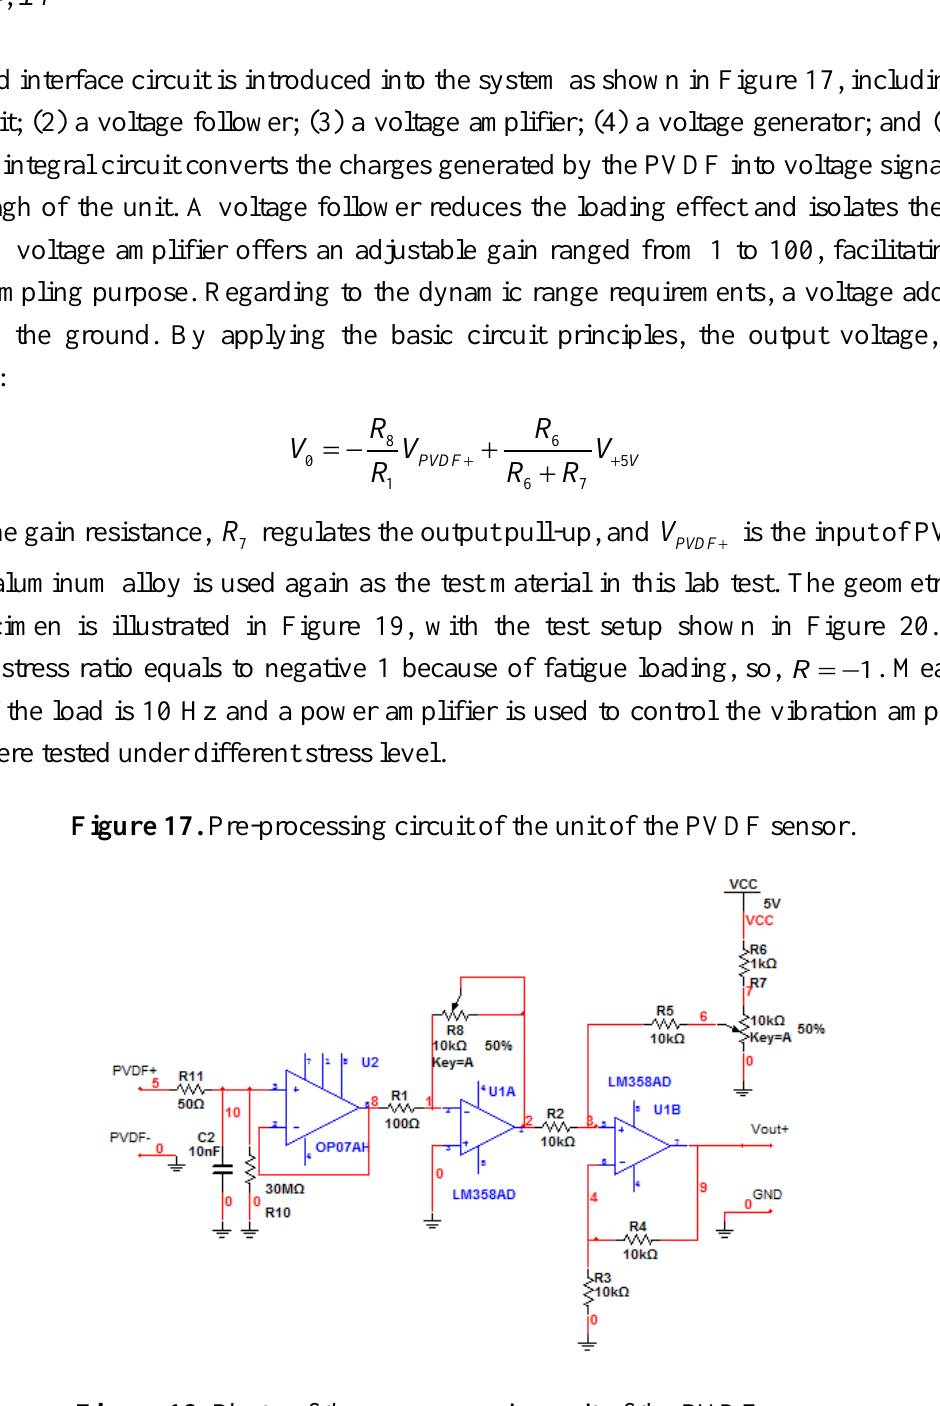
Figure 18. Photo of the pre-processing unit of the PVDF